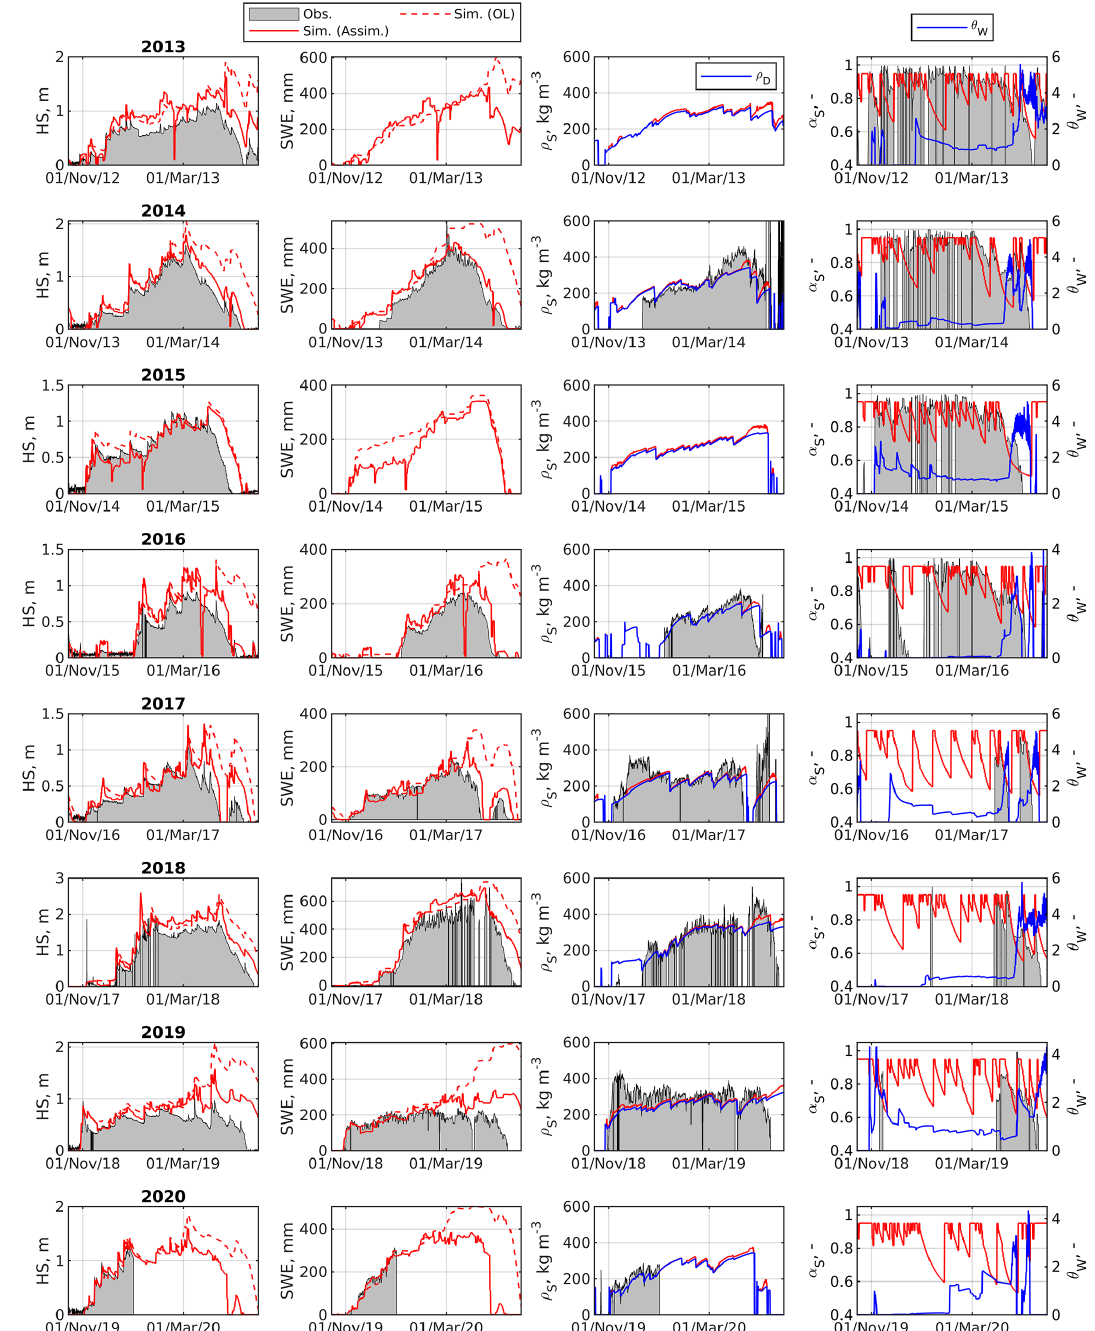
Figure 6. Comparison between measurements and modeling outputs at the Torgnon study plot. The first, second, third, and fourth columns are snow depth (HS), SWE, bulk-snow density, and albedo, respectively. The third and fourth columns also report dry-snow density and bulk volumetric liquid-water content, respectively. Each row is one water year (2013 to 2020). “OL” and “Assim.” stand for open-loop and assimilated simulations,